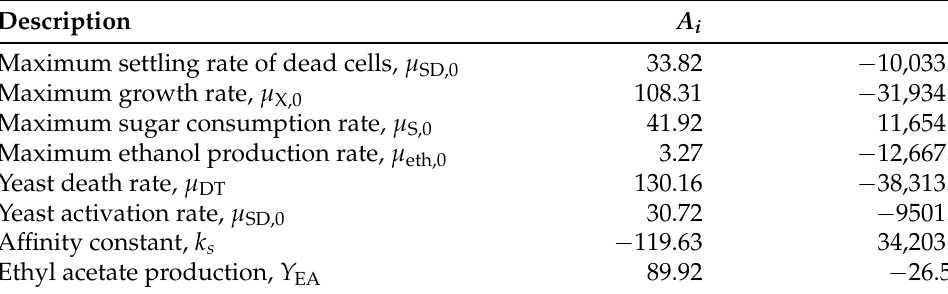
Table 2. Parameters in the Arrhenius-type rate